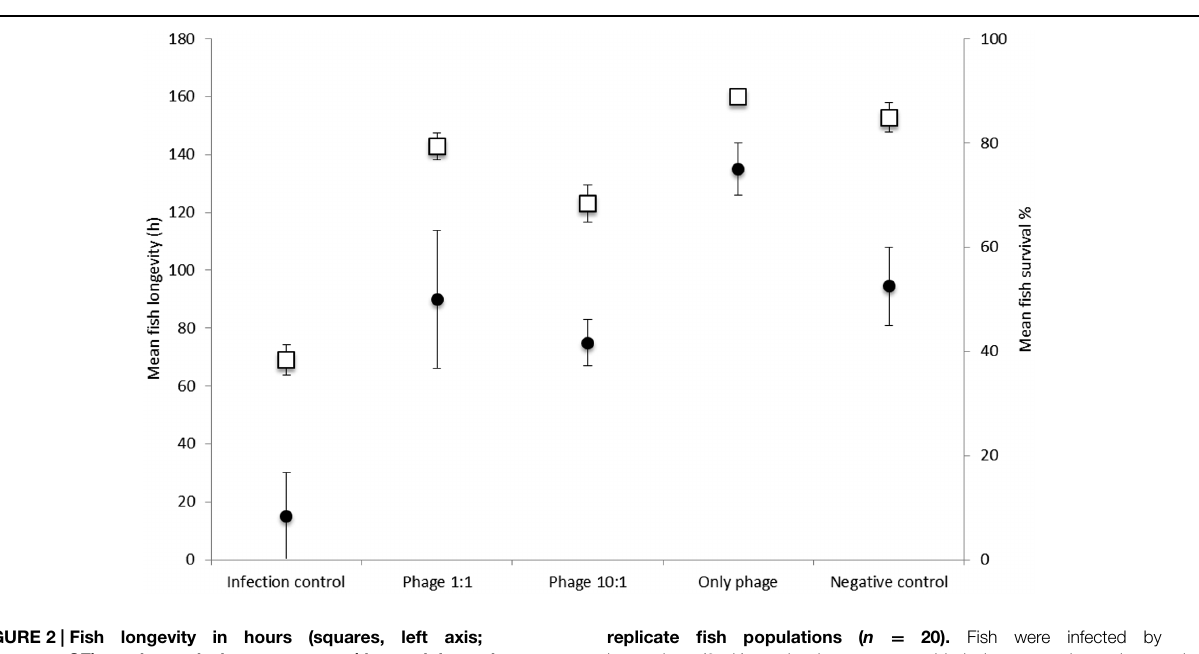
replicate fish populations ( n = 20). Fish were infected by immersion (2 h) and phage was added into experimental aquaria after bacterial challenge (in phage-to-bacterium ratios of 1:1 and 1:10). See Table 2 for statistical